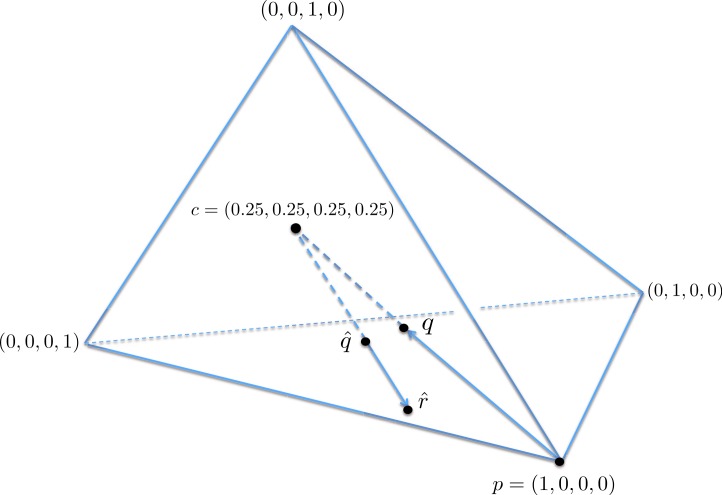
A geometric view of the correction process, showing the tetrahedron of all nucleotide distributions.When the true nucleotide distribution p is (1, 0, 0, 0), the limiting distribution after next generation sequencing q is along the line from p to the centroid c. Under sampling, we see nearby \documentclass[12pt]{minimal}
\usepackage{amsmath}
\usepackage{wasysym}
\usepackage{amsfonts}
\usepackage{amssymb}
\usepackage{amsbsy}
\usepackage{upgreek}
\usepackage{mathrsfs}
\setlength{\oddsidemargin}{-69pt}
\begin{document}
}{}$\hat {q}$\end{document}qˆ which is corrected to \documentclass[12pt]{minimal}
\usepackage{amsmath}
\usepackage{wasysym}
\usepackage{amsfonts}
\usepackage{amssymb}
\usepackage{amsbsy}
\usepackage{upgreek}
\usepackage{mathrsfs}
\setlength{\oddsidemargin}{-69pt}
\begin{document}
}{}$\hat {r}$\end{document}rˆ, lying on the extension of the line from c to \documentclass[12pt]{minimal}
\usepackage{amsmath}
\usepackage{wasysym}
\usepackage{amsfonts}
\usepackage{amssymb}
\usepackage{amsbsy}
\usepackage{upgreek}
\usepackage{mathrsfs}
\setlength{\oddsidemargin}{-69pt}
\begin{document}
}{}$\hat {q}$\end{document}qˆ.